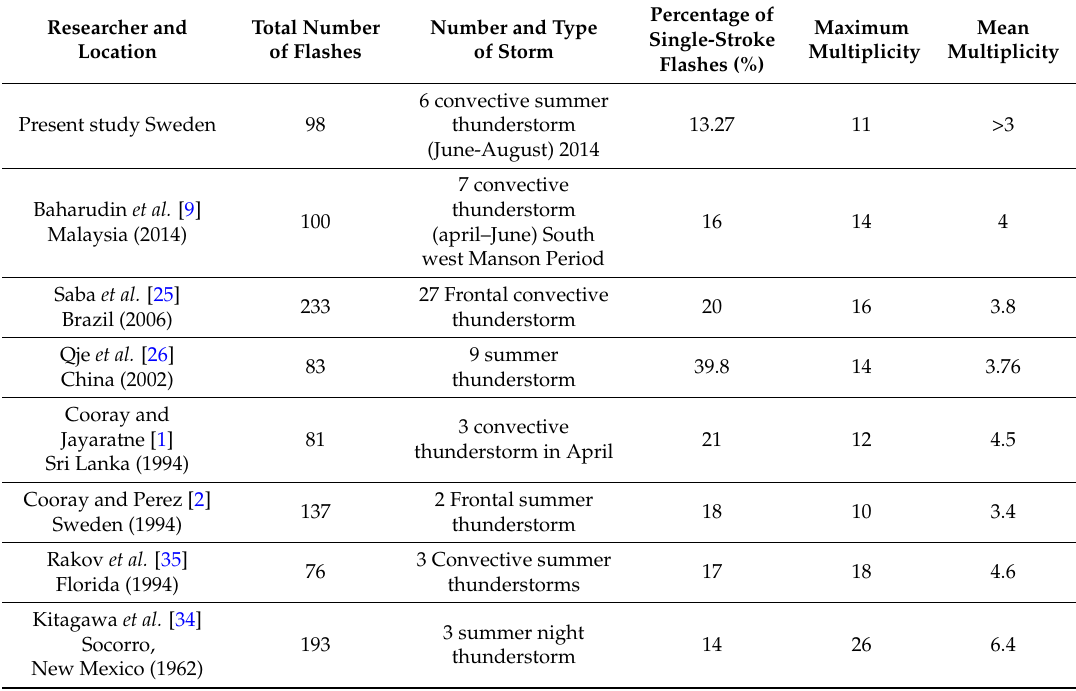
Table 9. Distribution of number of strokes per